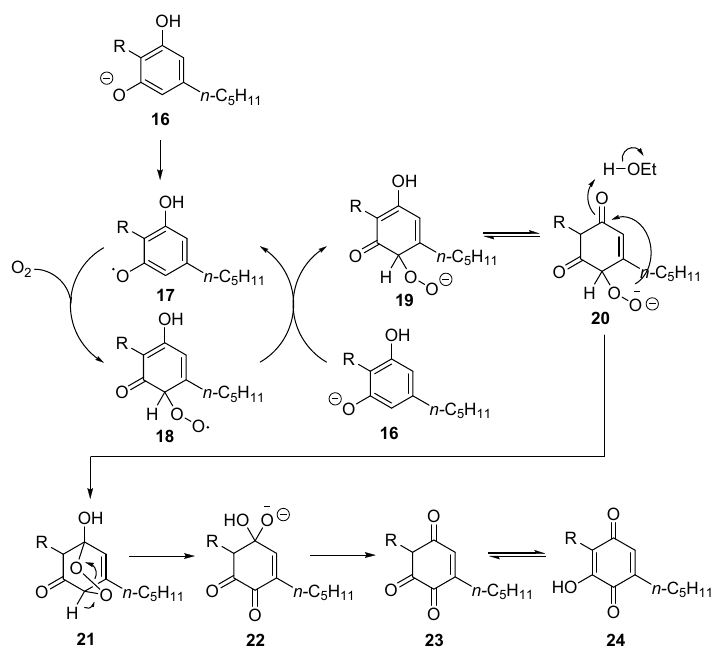
Scheme 1. Base-promoted autooxidation of diphenolic cannabinoids to quinones ( 23 and 24 ) (Beam reactionvia intermediates 16–22 (R = terpenyl).